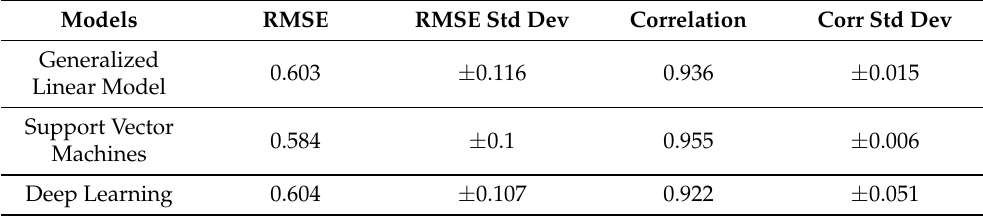
Table 4. Results on Test Set for Generalized Linear Model, Support Vector Machines and Deep